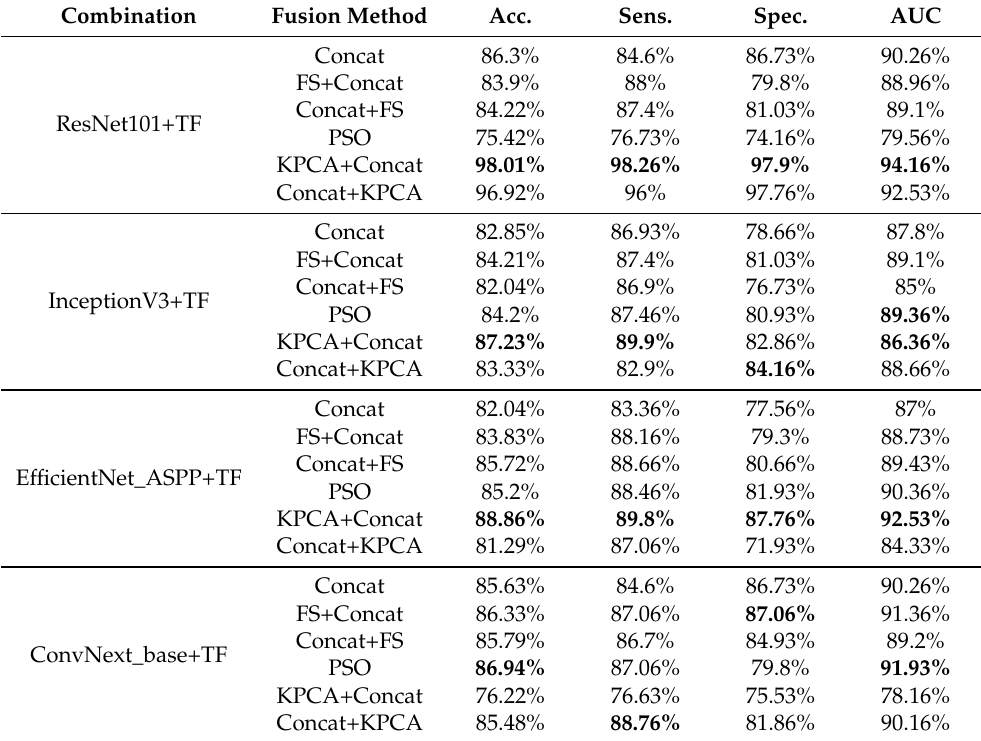
Table 7. Results obtained on GE9 through various combination